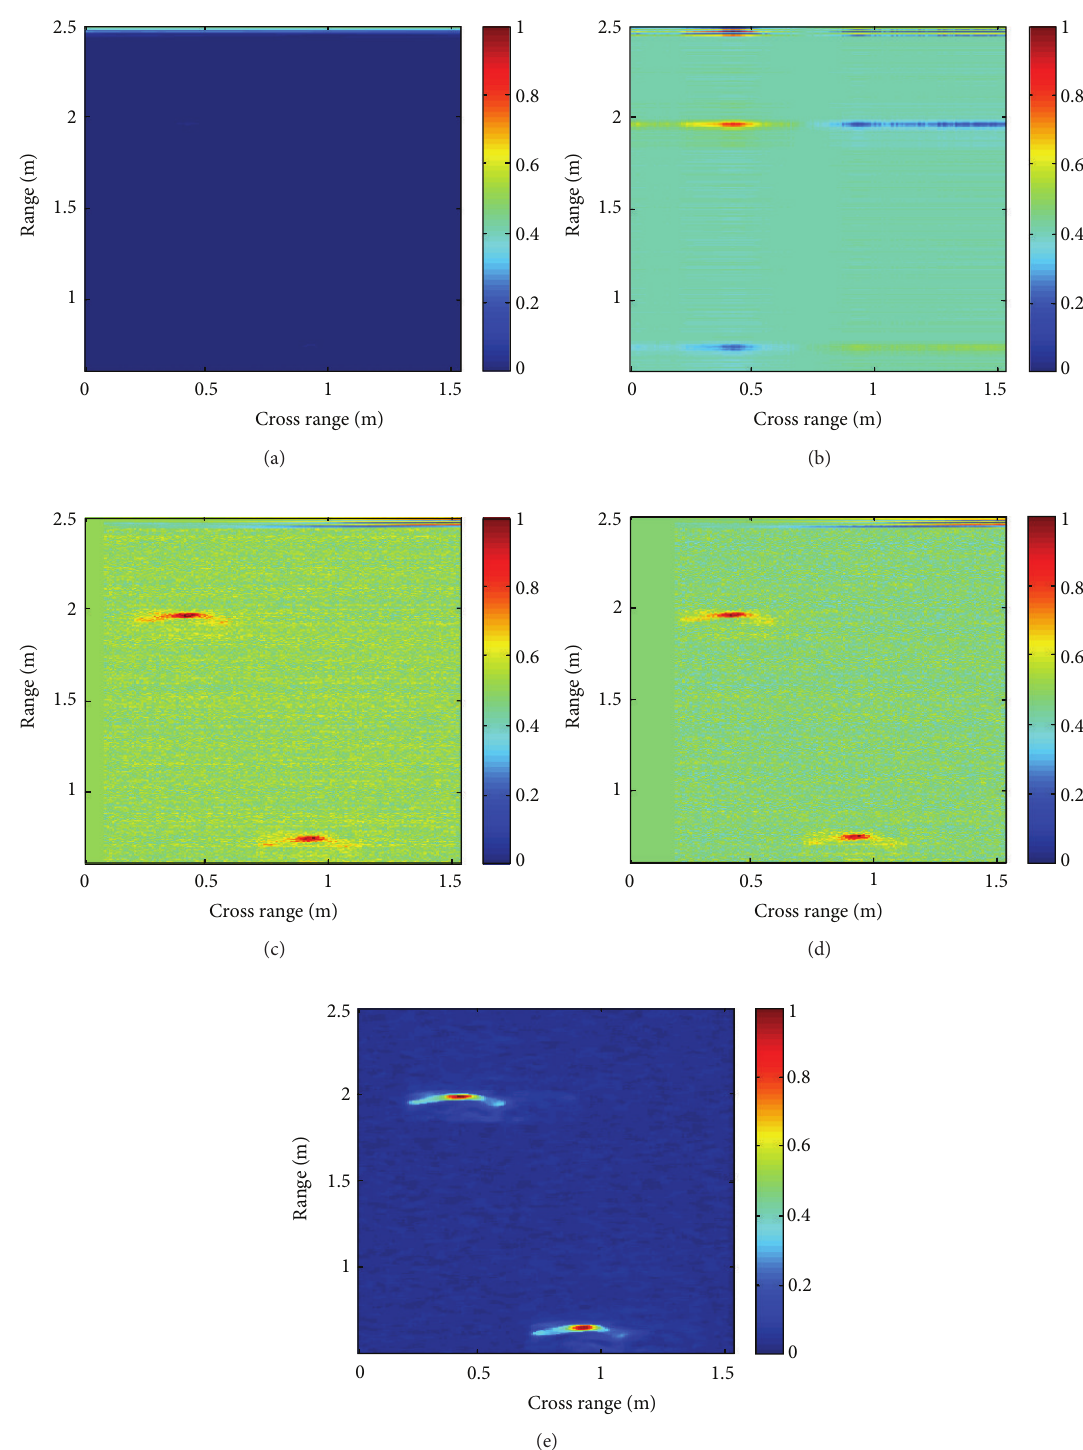
Figure 1: Image with two targets. (a) Original image. (b) SVD [11]. (c) Proposed fuzzy QRD (PIE). (d) Proposed fuzzy QRD (TS). (e) Background subtracted reference